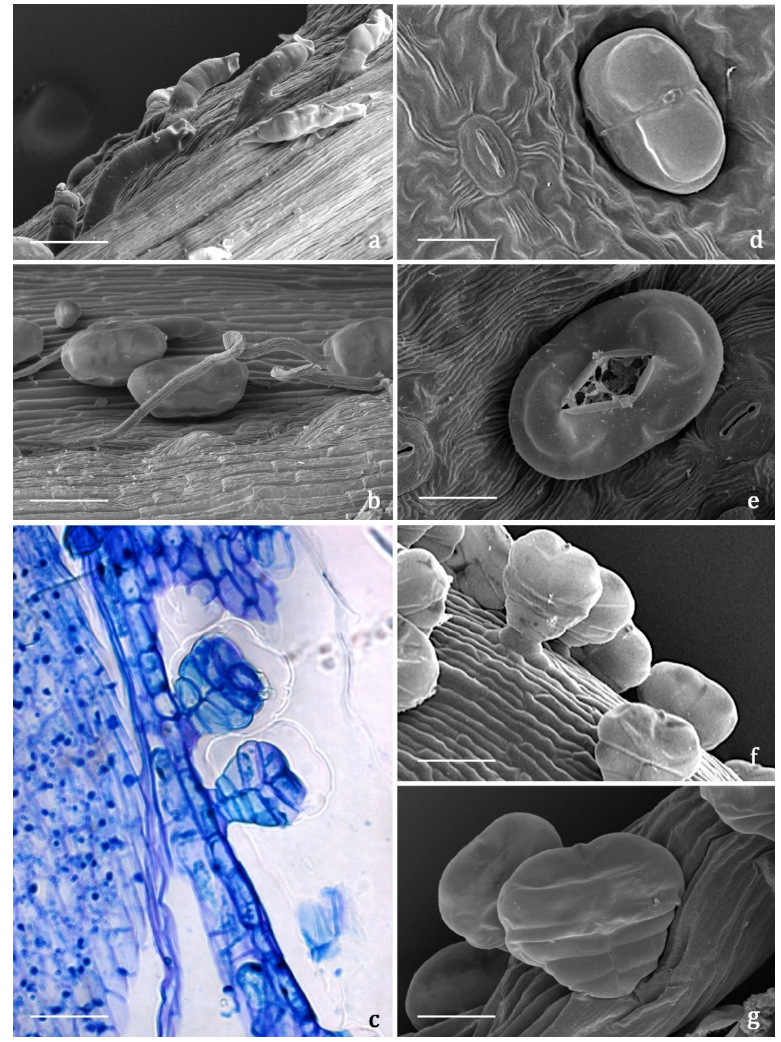
Figure 4. SEM and LM micrographs showing the covering and glandular trichomes observed on the vegetative and reproductive organs of Achillea moschata . ( a ) Short digitiform trichomes. ( b ) Long filamentous trichome and biseriate glandular trichomes. ( c ) Longitudinal section of biseriate 10- celled glandular trichomes stained with Toluidine Blue. ( d ) Sunken biseriate glandular trichome with intact cuticle. ( e ) Sunken glandular trichome showing the rupture of the cuticle along a line of weakness. ( f , g ) Protruding biseriate 10-celled glandular trichomes. Scale bars: 50 μ m ( a–c , f ); 20 μ m ( d , e , g ).